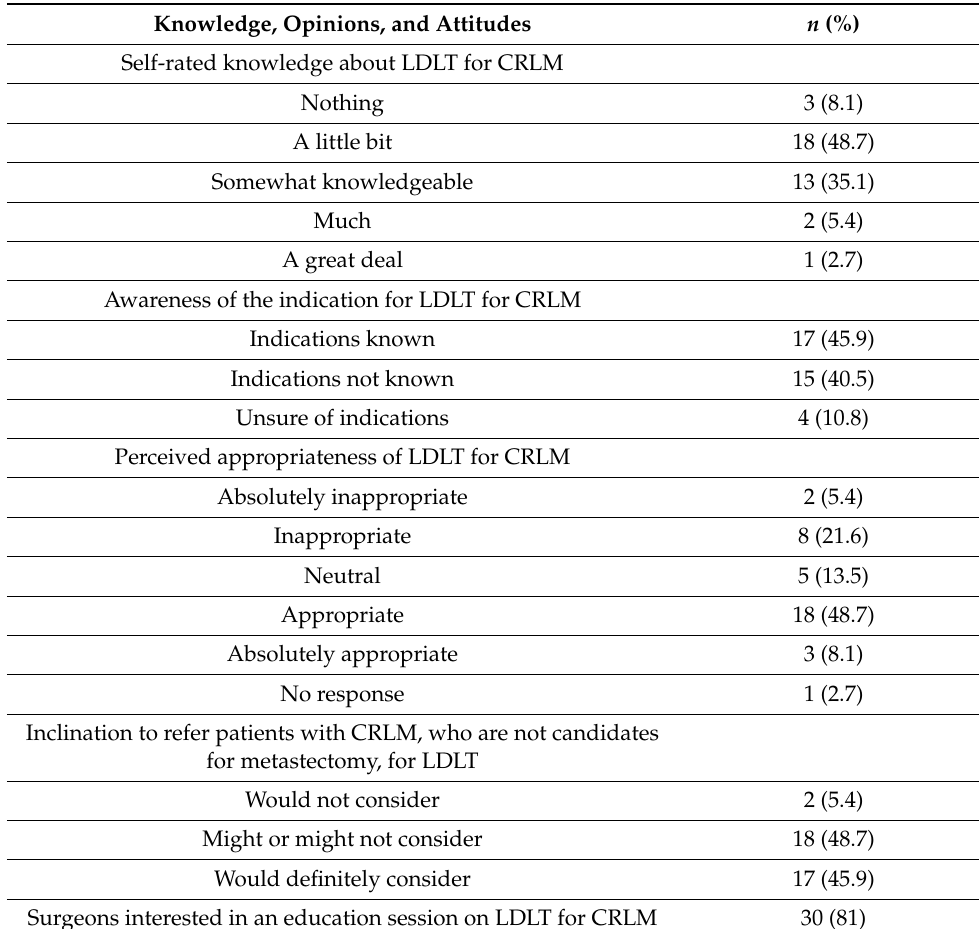
Table 3. Knowledge, opinions, and attitudes towards living donor liver transplant for colorectal liver